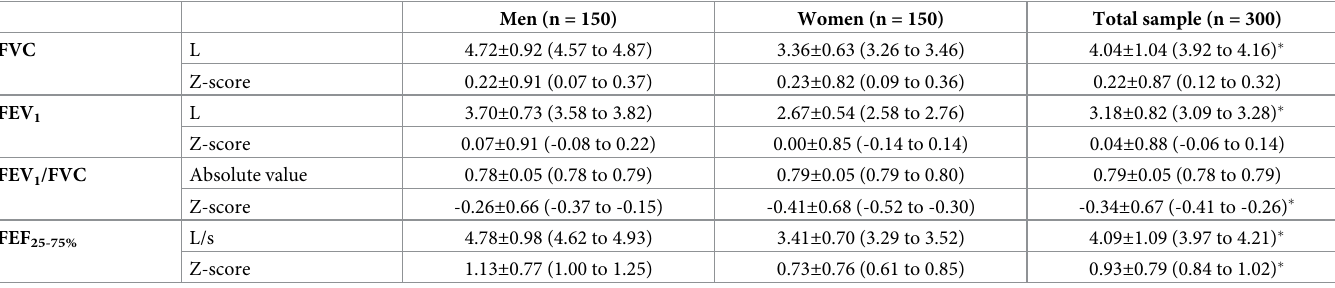
Table 2. Spirometric data of the healthy non-smoker adults aged 18–85